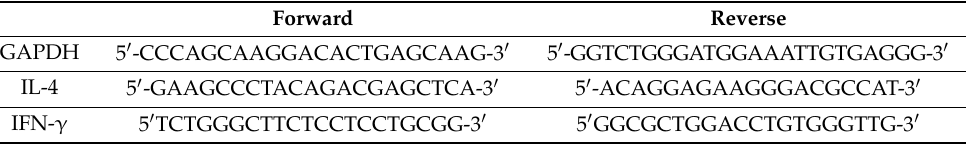
Table 1. Quantitative polymerase chain reaction primers for GAPDH, IL-4, IFN- γ , mRNA.